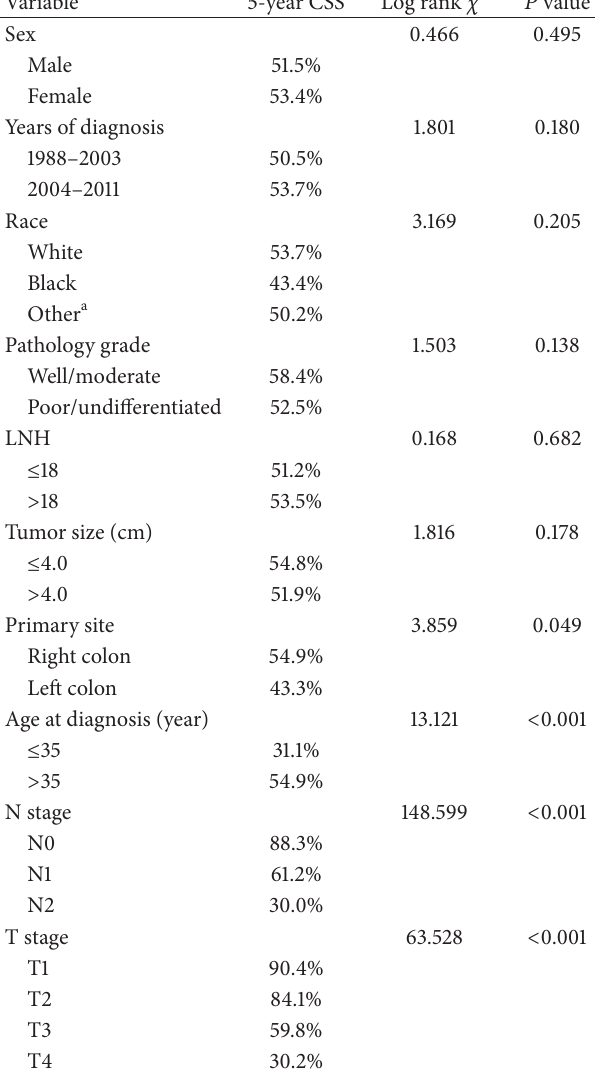
Table 2: Univariate analyses of determinants of cancer-specific sur- vival(CSS)ofpatientswithnonmetastaticsignet-ringcellcarcinoma of the